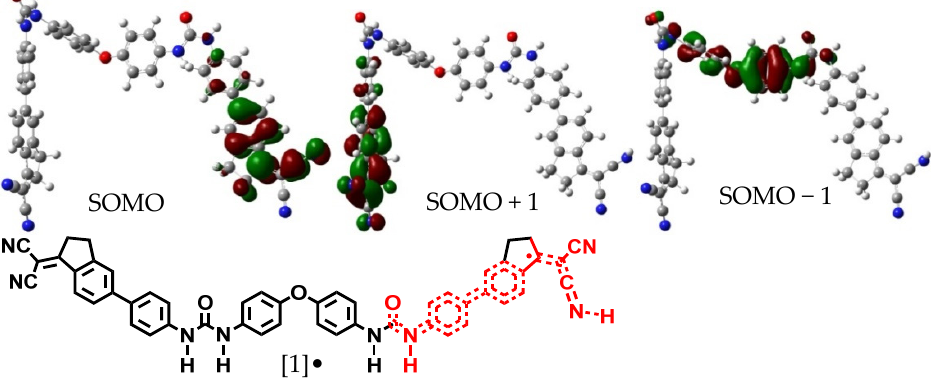
Figure 8. Singly occupied molecular orbital (SOMO), SOMO + 1, and SOMO − 1 for compound [ 1 ] • .